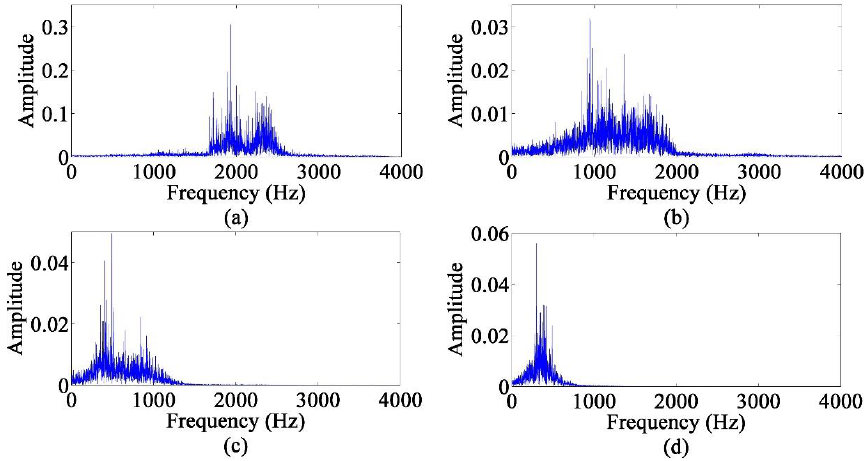
Figure 12. The amplitude spectra of each IMF after EMD. ( a ) IMF1. ( b ) IMF2. ( c ) IMF3. ( d ) IMF4.